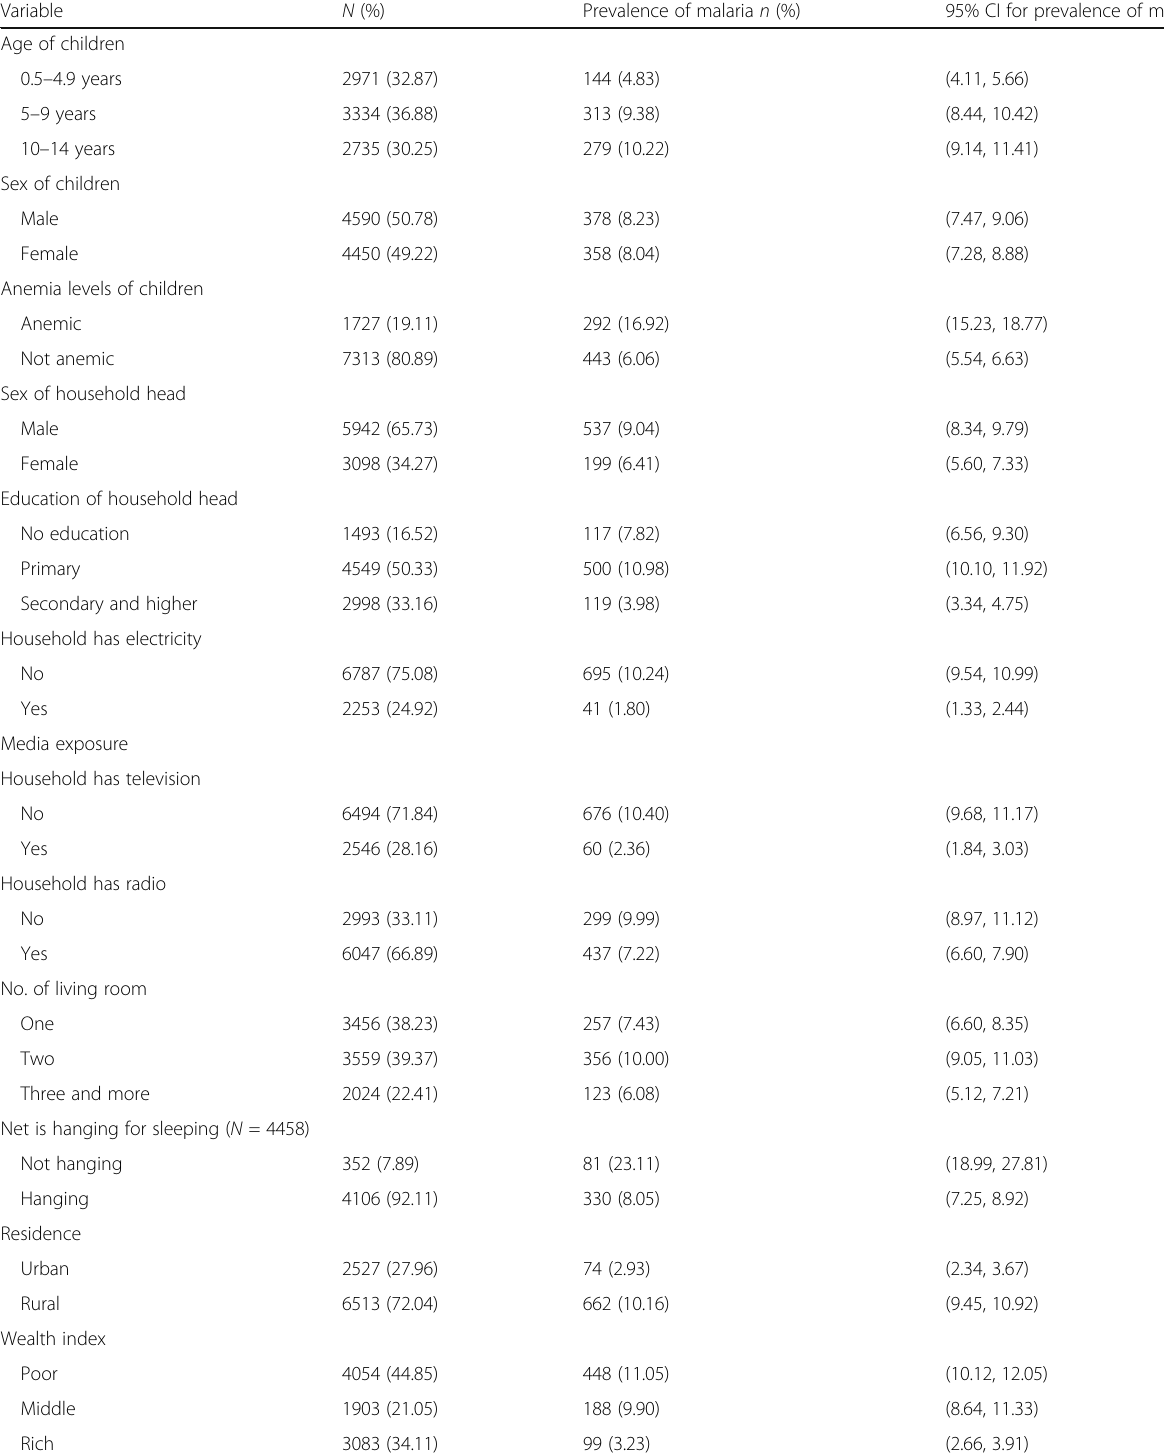
Table 1 Distribution of the prevalence malaria among 6-month to 14-year children on sociodemographic characteristics ( N = 9040) Variable N (%) Prevalence of malaria n (%) 95% CI for prevalence of